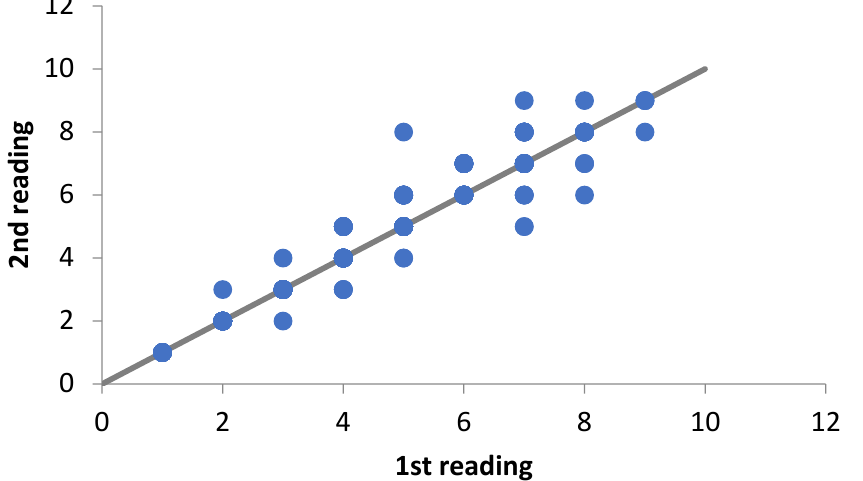
Figure 2. Error in the number of band pairs counted from Urotrygon microphthalmum captured in northeastern Brazil. The gray diagonal line indicates a one-to-one relationship.